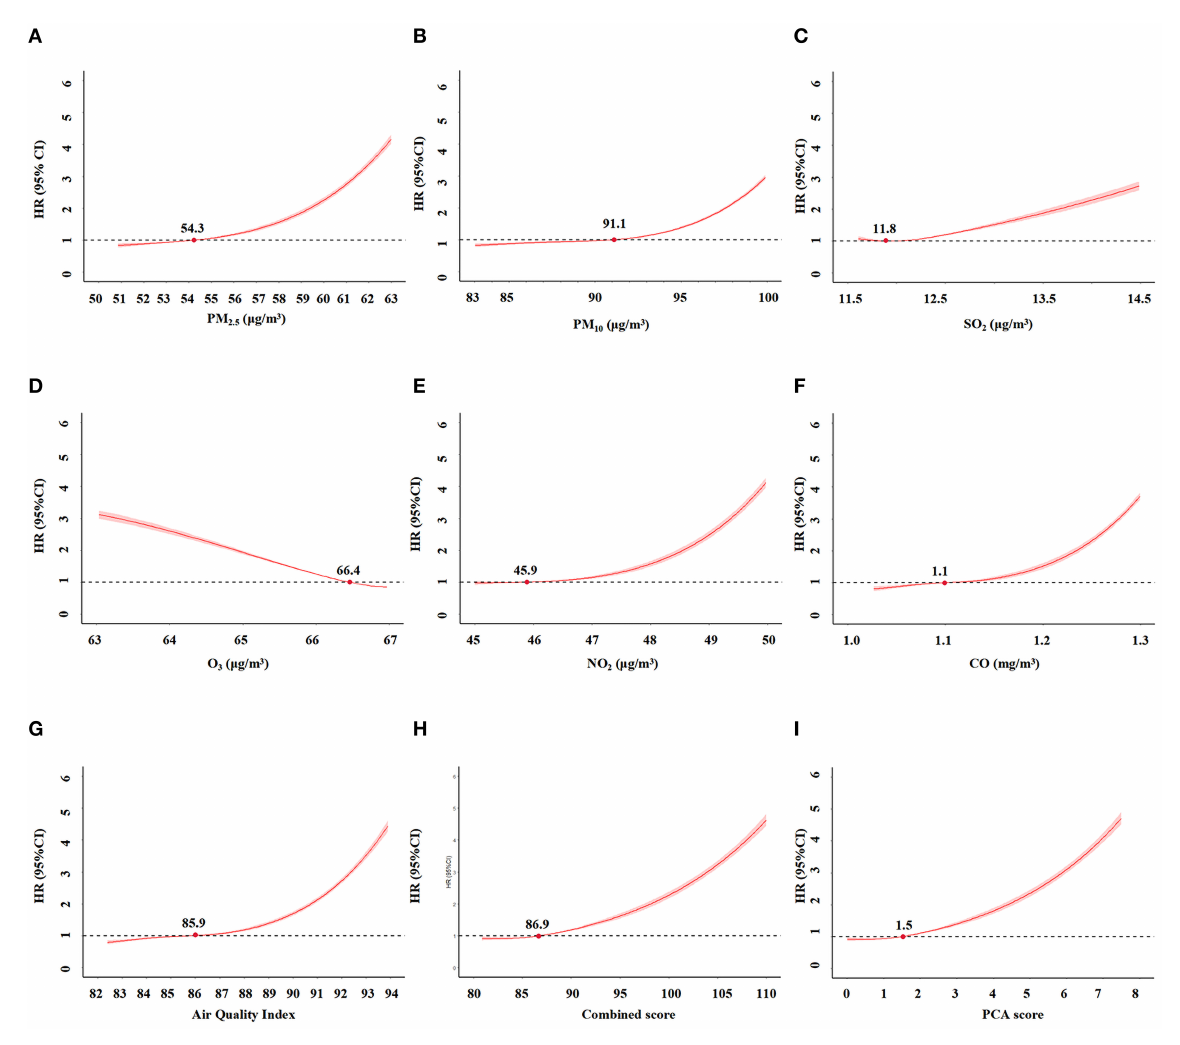
FIGURE4 The relationships between air pollution indicators and incident CKD by restriction spline regression. (A) PM 2.5 . (B) PM 10 . (C) SO 2 . (D) O 3 . (E) NO 2 . (F) CO. (G) Air Quality Index (AQI). (H) combined score of all pollutants. (I). PCA